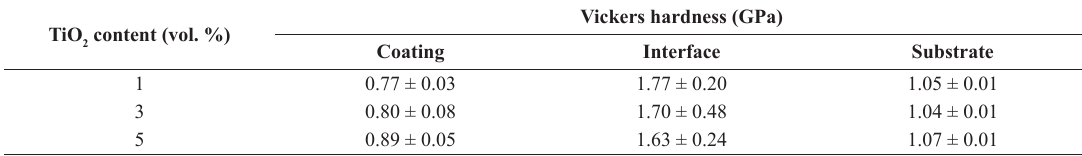
Table 1. Vickers microhardness values of the Ni-TiO TiO content (vol. %) 2